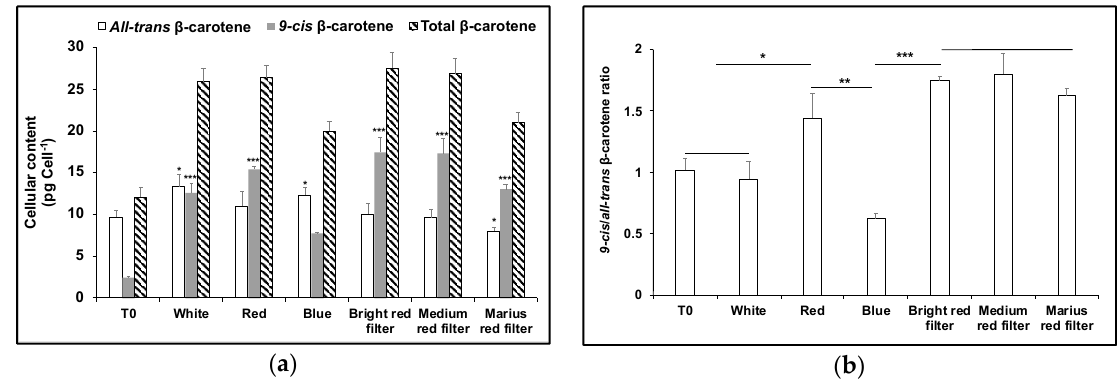
Figure 6. Cultivation of D. salina using red light filters. D. salina was cultivated under white light to early orange phase (cell density of ~0.5 × 10 6 cells mL − 1 ; carotenoid: chlorophyll ratio ~3), and then cultures were diluted with fresh medium to a cell density of ~0.2 × 10 6 cells mL − 1 (no nutrient stress) (T0) and then further cultivated for 48 h under white, red or blue LED light at 1000 µ mol m − 2 s − 1 or under white LED light at 1000 µ mol m − 2 s − 1 covered with one of three di ff erent red filters (Lee filter 26 Bright red; Lee filter 27 Medium red; or Lee filter 787 Marius red). ( a ) Cellular content of 9-cis , all-trans and total β -carotene. ( b ) 9-cis / all-trans β -carotene ratio. Results were analysed by one way ANOVA and Tukey multiple pairwise-comparisons. Asterisks represent di ff erent levels of significance (*** 0 < p ≤ 0.001, ** 0.001 < p ≤ 0.01, * 0.01 < p ≤ 0.05). The co-regulation by light and temperature on the β -carotene production and isomeric composition in D. salina is shown in Figure 7. Cultivation at 15 ° C compared to 25 ° C increased the 9-cis / all-trans β C ratio, especially under red light, but decreased the pool size of β -carotene measured over the same time frame (48 h).